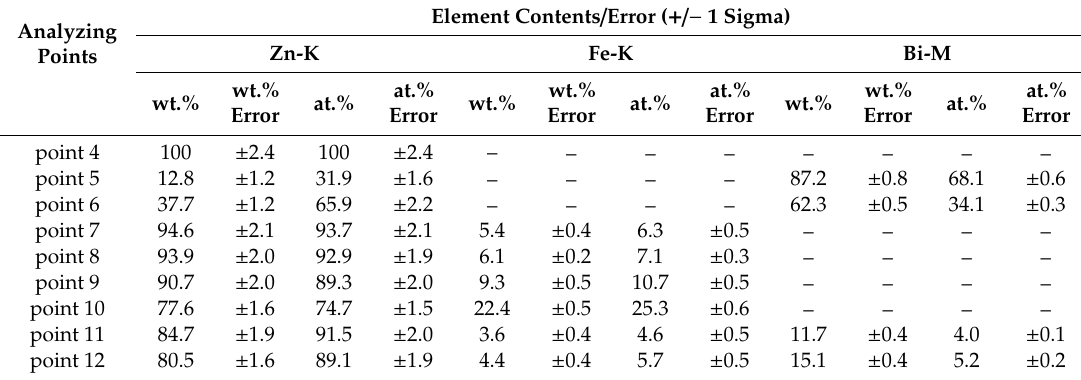
Table 4. The chemical composition in chosen micro-areas on the Zn-AlNiBi coating cross-section (analysis points marked on Figure 5).